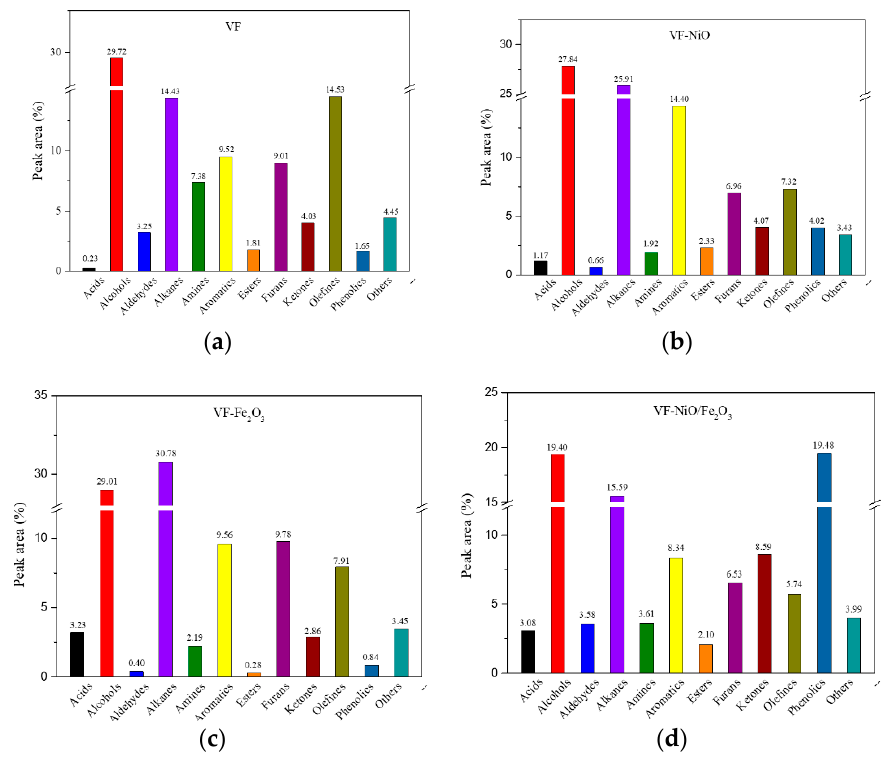
Figure 5. Chemical composition of bio-oil vapor released from fast pyrolysis of Vernicia fordii wood (VF) samples that were sorted by common functional groups. ( a ) VF, ( b ) VF-NiO, ( c ) VF-Fe 2 O 3 , and ( d ) VF-NiO/Fe 2 O 3 .